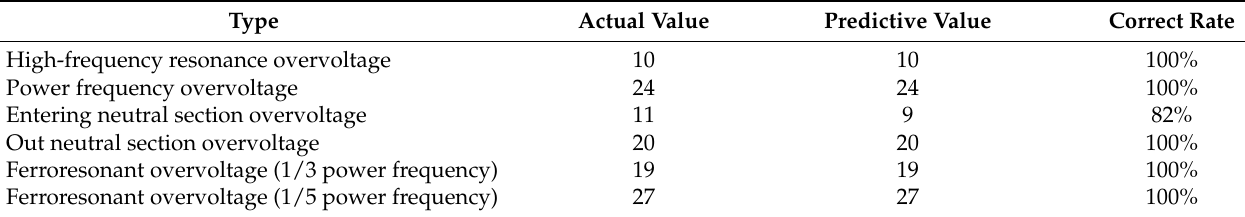
Table 1. The results of model